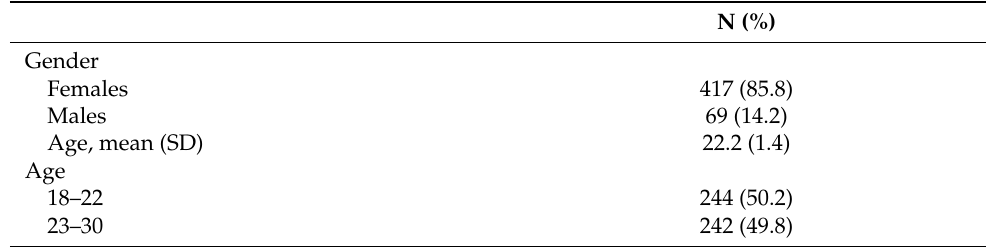
Table 1. Sample characteristics for total sample (N = 501).